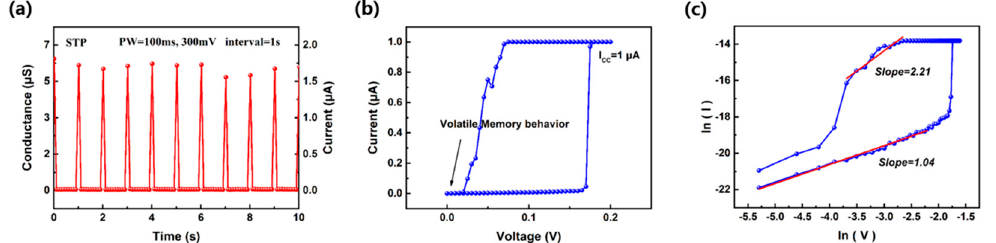
Figure 5. “learning and forgetting” ability in Ag/HfO 2 /Pt synaptic devices. ( a ) Nonlinear increase